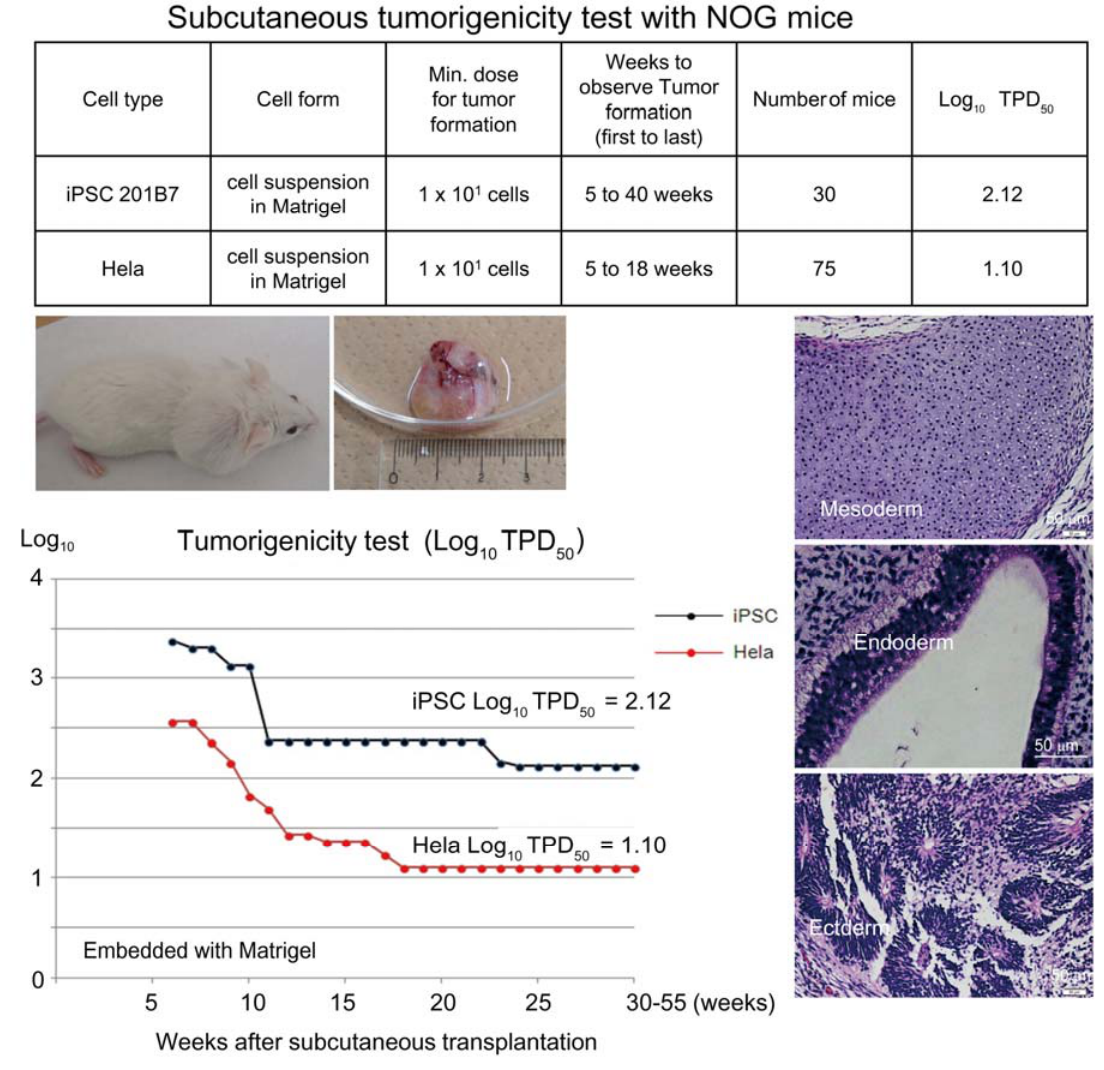
Figure 1. Subcutaneous tumorigenicity test with NOG mice. A table in above showed type of cells used as a positive control for tumorigenicity test (iPSC cell line 201B7 and tumor cell line HeLa), minimum dose for tumor formation and Log 10 TPD 50 for them when transplanted subcutaneously with Matrigel ® . A line graph showed value for Log 10 TPD 50 for iPSC or HeLa at respective monitoring point (0–55 weeks). Photos (clock-wise); NOG mouse with tumor, teraoma from NOG mouse, Slice section of teratoma after HE staining; cartilage (mesoderm), intestinal tissue-like (endoderm) or neural rosette-like (ectoderm)